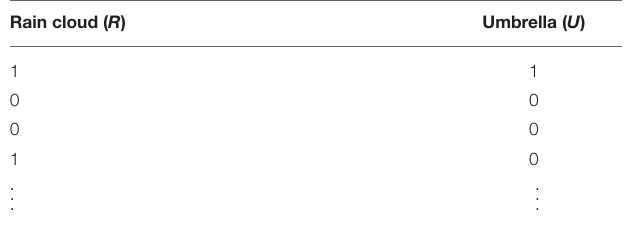
TABLE 1 | Example observations of the presence of certain objects in a scene. Rain cloud ( R